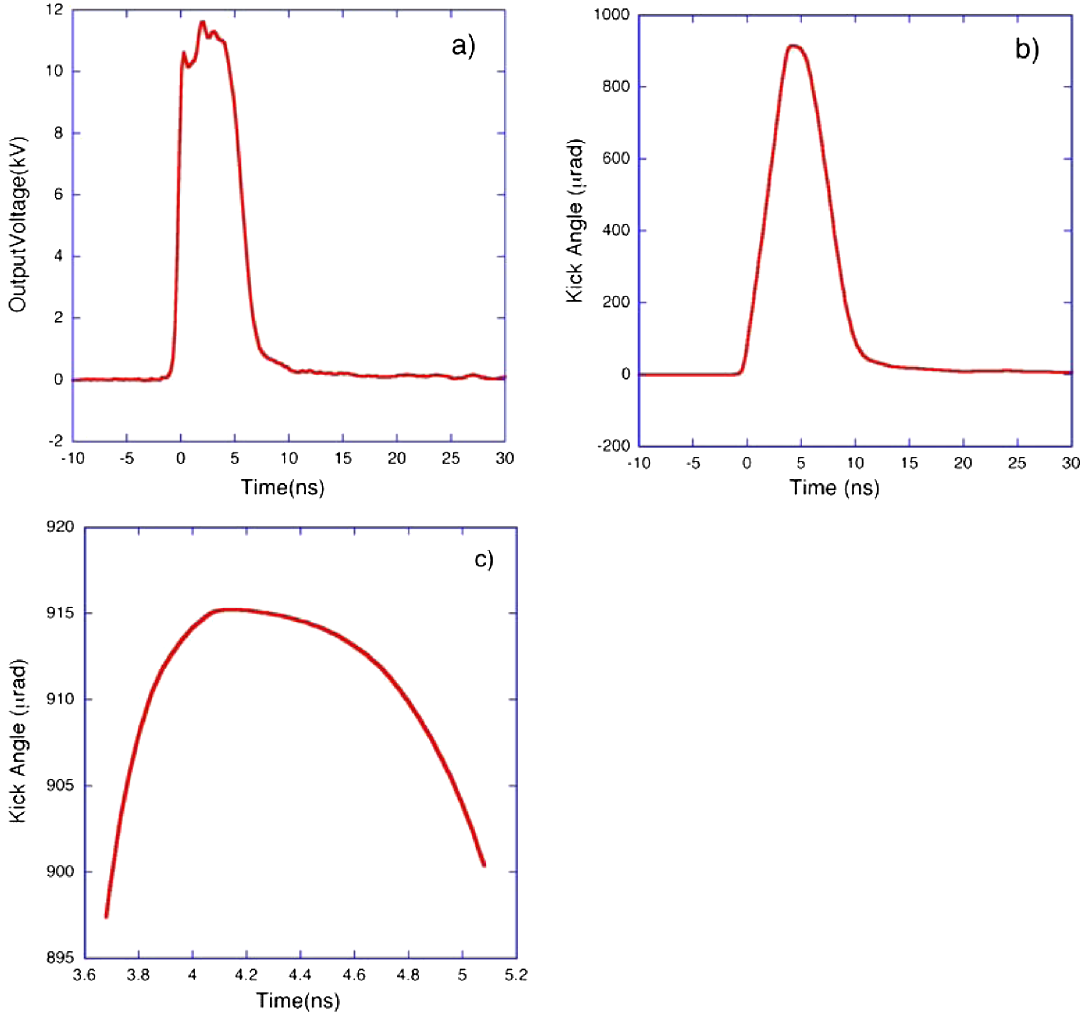
FIG. 2. (a) The waveform of the kicker pulse (positive polarity); (b) the estimated kick field as a function of time when the kicker pulse is applied to a 60-cm-long strip line; (c) the expanded peak area of the estimated kick field: There is a continuous change in the kick angle as a function of time, and the gradient does not fall to zero for any more than an instant for a period of less than 200